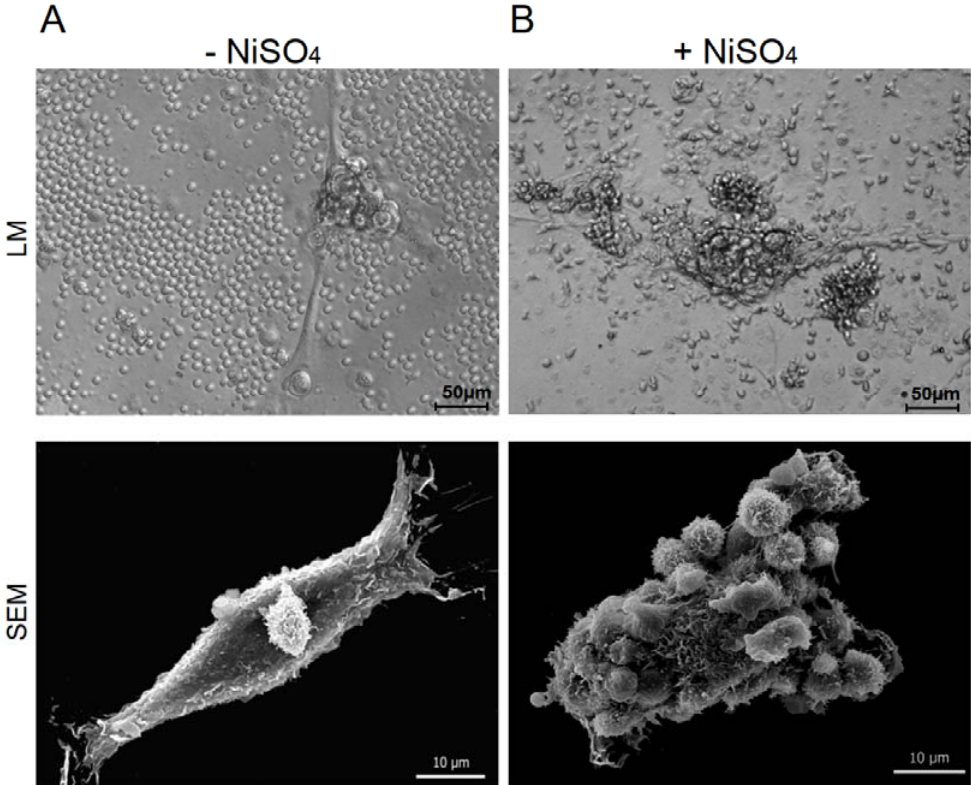
Figure 1. Keratinocytes and nickel-specific T cell clones interact in an autologous in vitro model of allergic contact dermatitis. Nickel-specific T cell clones were incubated together with autologous DCs and keratinocytes in the absence ( A ) or presence ( B ) of their specific antigen. The interaction of T cells and keratinocytes was monitored in light microscopy (LM) and scanning electron microscopy (SEM).